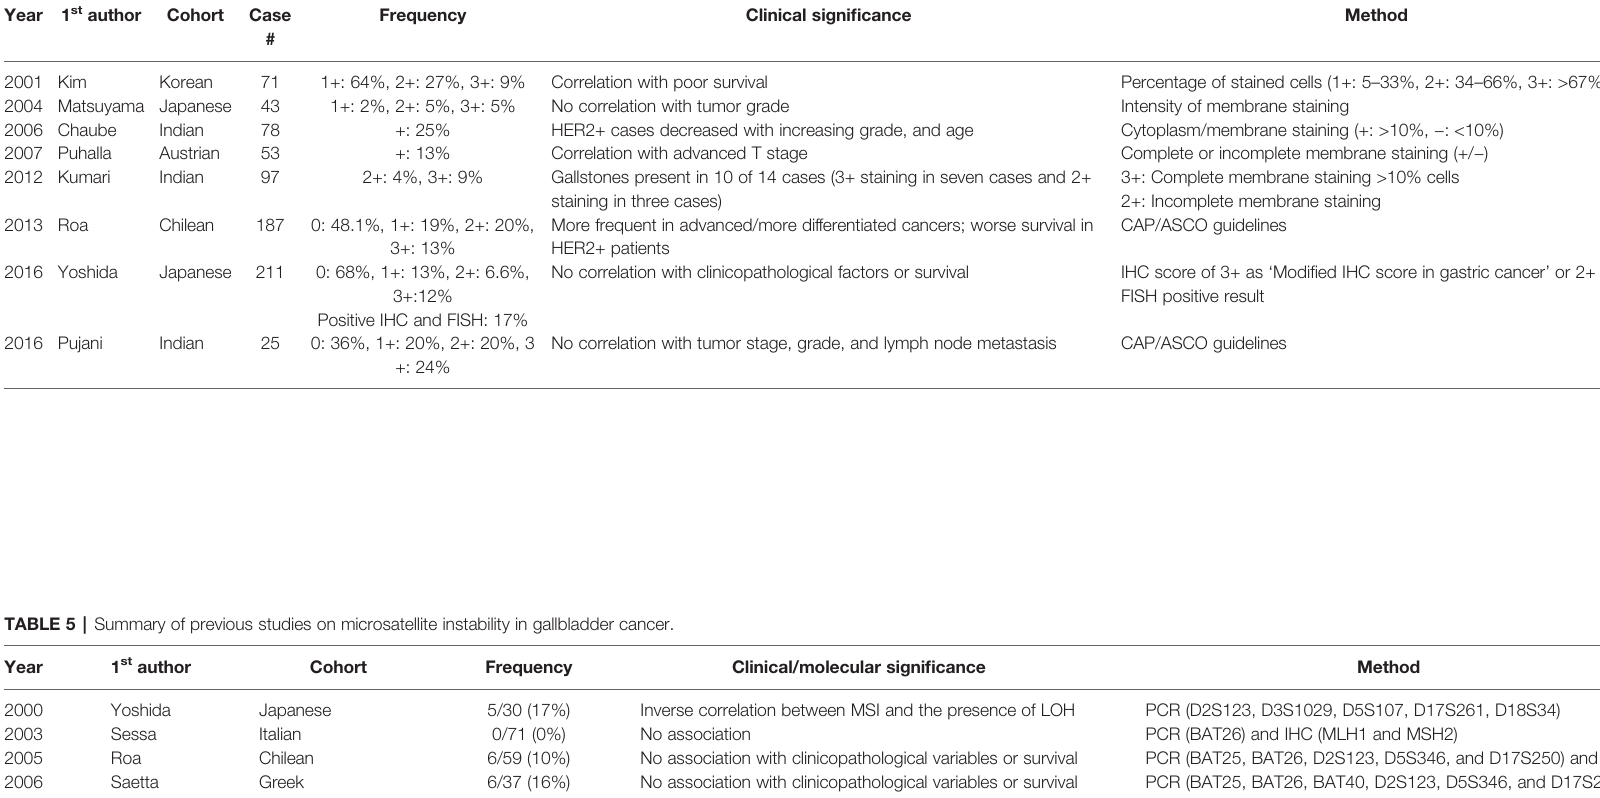
TABLE 4 | Summary of previous studies on HER2 expression in gallbladder cancer.